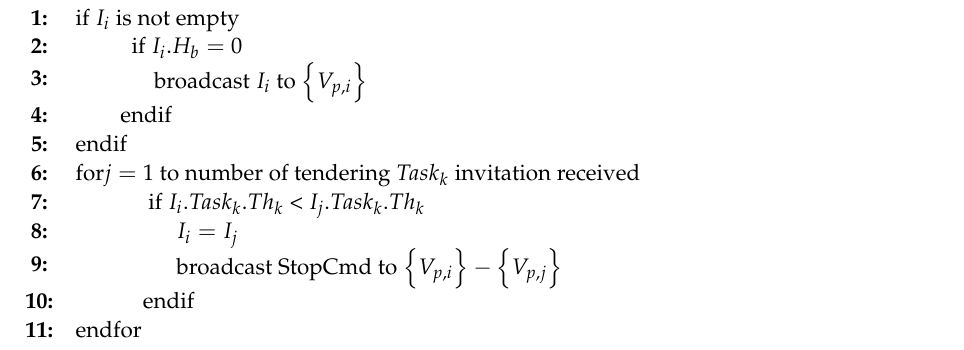
Algorithm 1: Release tendering information and achieve information